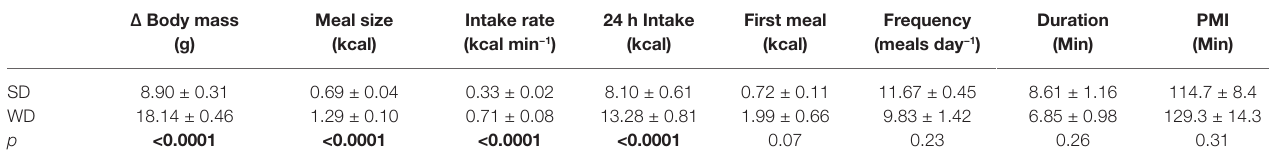
TABLE 2 | Consumption of WD is associated with